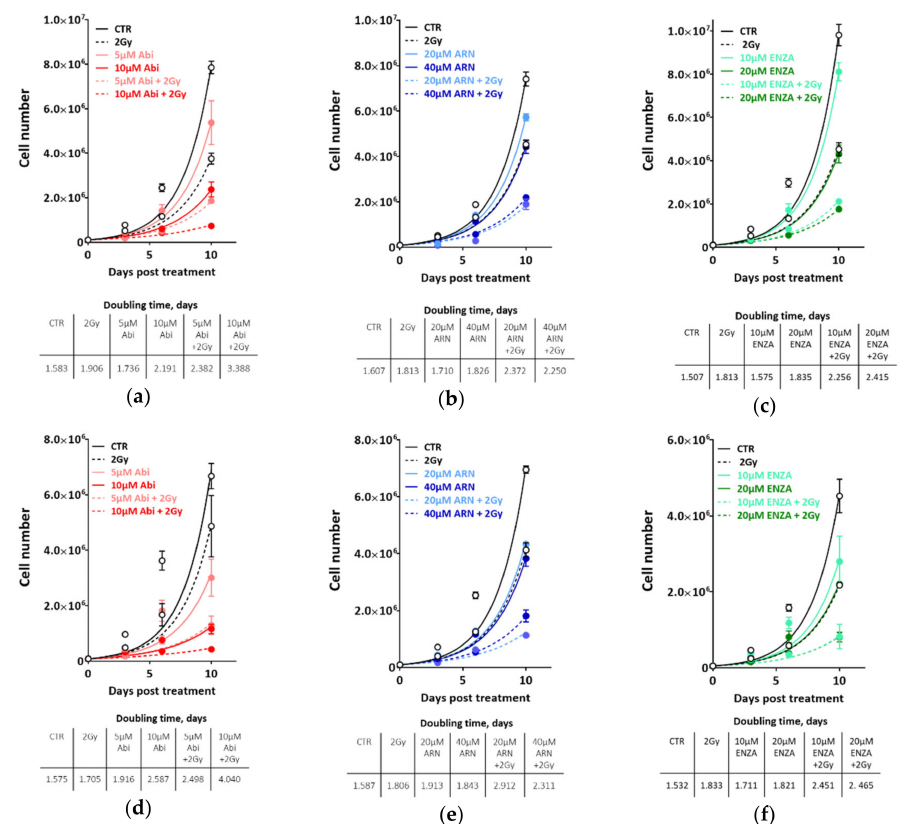
Figure 2. ADT potentiates the cytotoxicity of ionizing radiation in both hormone sensitive LNCaP and hormone resistant C4-2B cells. Cell number was determined in LNCaP ( a – c ) or C4-2B cells ( d – f ) on days 0, 3, 6 and 10 post treatment, with the indicated concentrations of abiraterone acetate ( a , d ), apalutamide (ARN) ( b , e ) or enzalutamide (ENZA) ( d , f ). Cell doubling time in days was calculated for each treatment, by fitting exponential growth curves using GraphPad Prism 7. Shown are means ± SEM of at least three independent